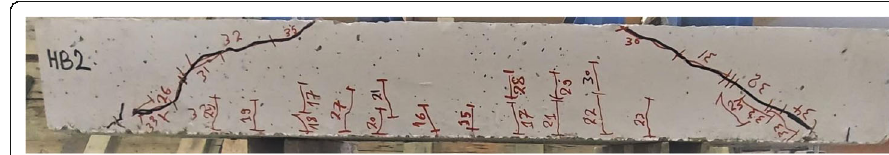
Fig. 8 Crack patterns at failure for shallow wide tested beam